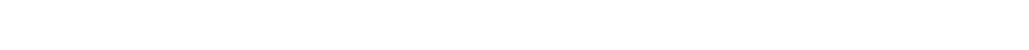
Frontiers in Materials | Optics and